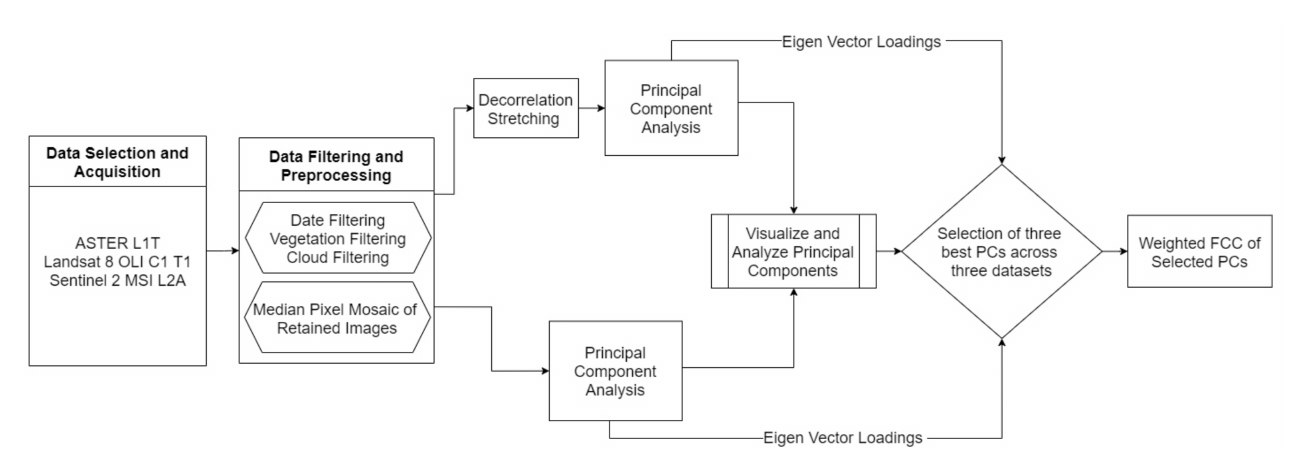
Figure 3. Schematic chart of the applied